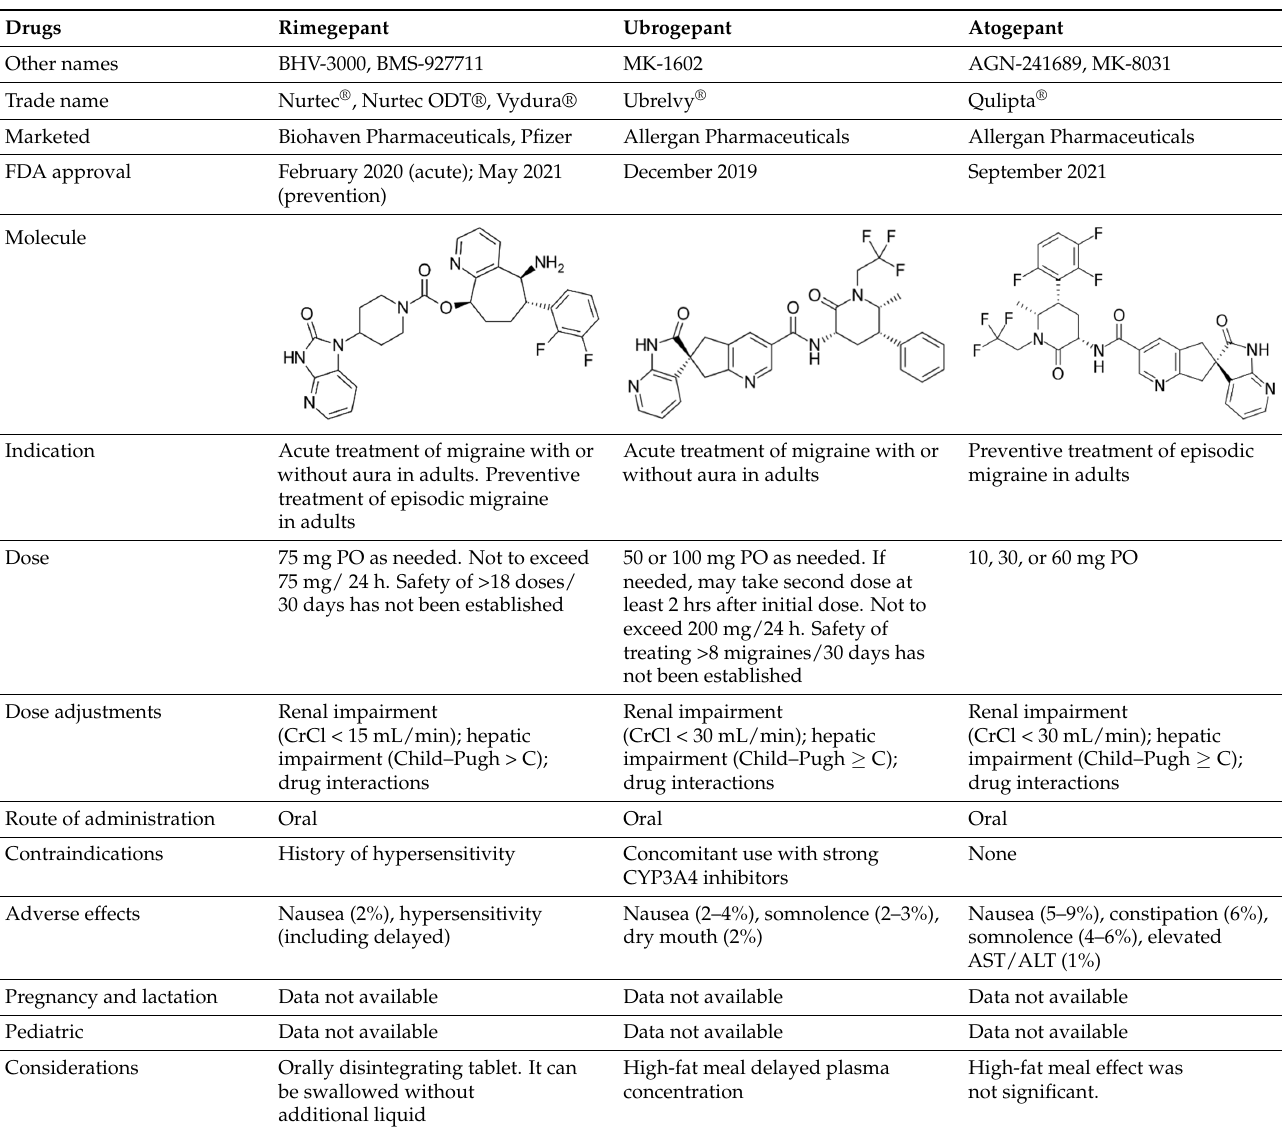
Table 1. Comparative analyses of pharmacokinetics, dosage, and formulations of rimegepant, ubrogepant, and atogepant.